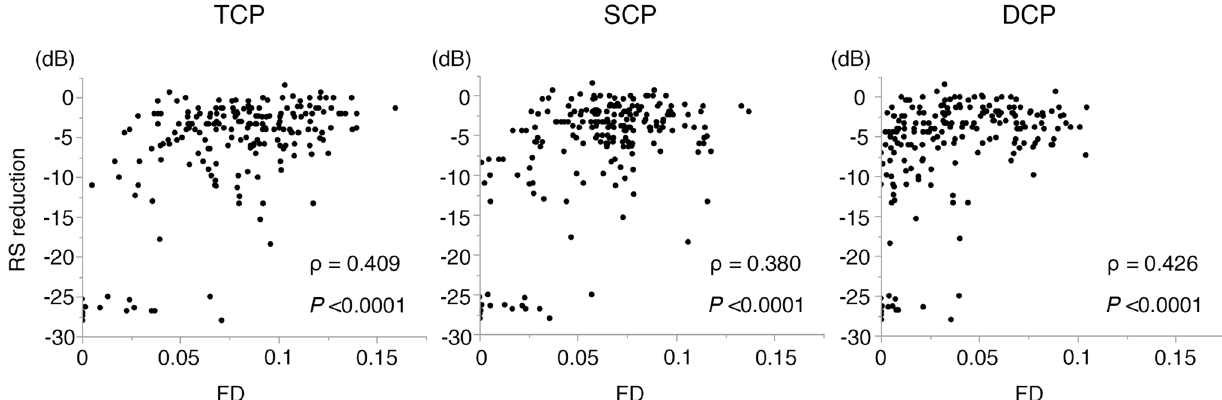
Figure 1. Correlations between flow density and reduction in retinal sensitivity. Scatter plots of TCP-FD, SCP-FD, or DCP-FD versus reduction in RS. Spearman’s correlation coefficient (ρ) was calculated. FD flow density, RS retinal sensitivity, TCP total capillary plexus layer, SCP superficial capillary plexus layer, DCP deep capillary plexus